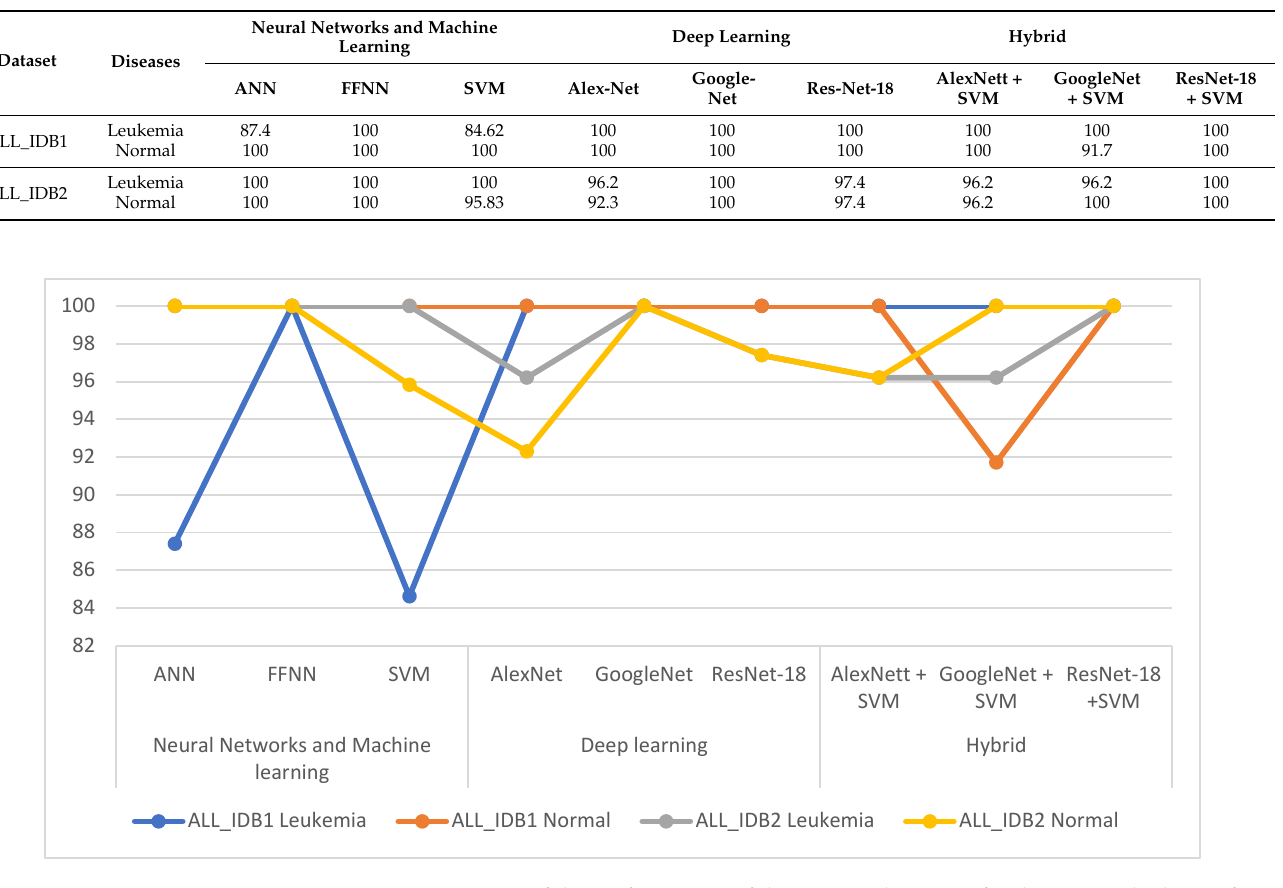
Table 8. Comparing the performance of the proposed systems with the performance of the relevant previous studies.